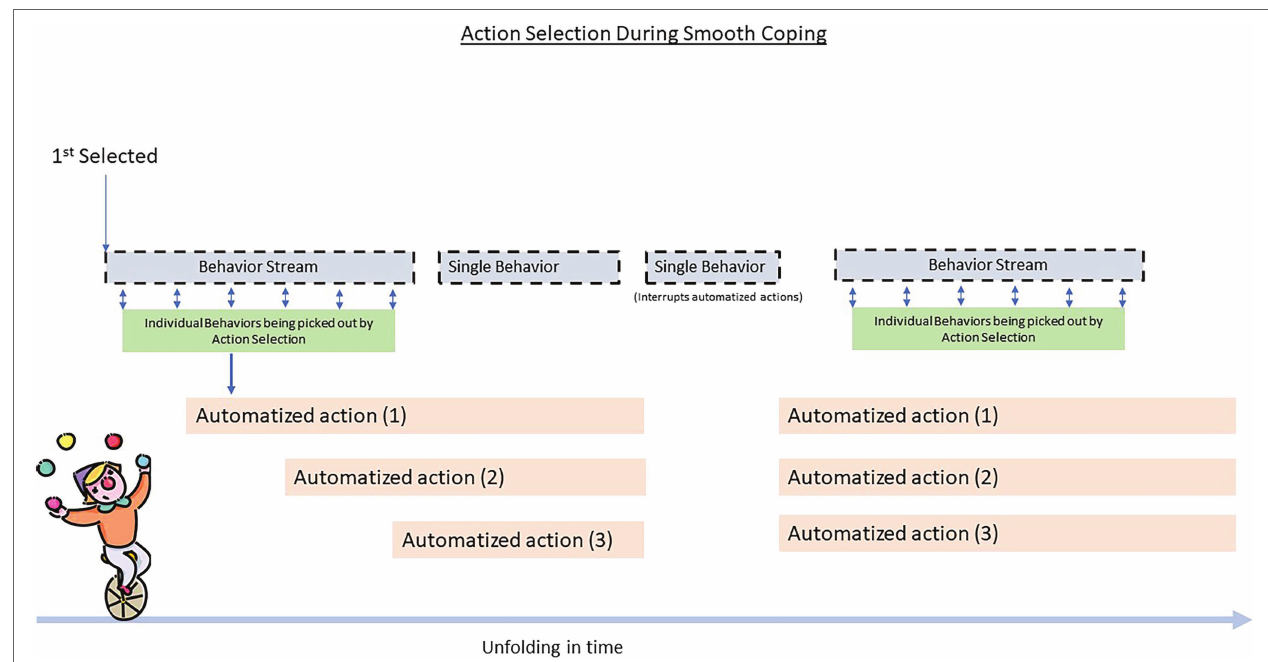
FIGURE 8 | Here, we see an example of how an instance of smooth coping could unfold in a LIDA agent. The clown initiates automized actions, such as biking, juggling, and perhaps singing. In this case, the clown starts by biking, then overlays juggling, and finally starts singing (three concurrent automatized behaviors). Intermixed with these automized actions are behaviors picked out from a behavior stream and single behaviors. For example, the clown can turn its head toward select audience members and do a terrifying grin, perhaps do a spin on the bike or in the case of the single behavior that stops all other actions—do a backflip on the bike to then continue the